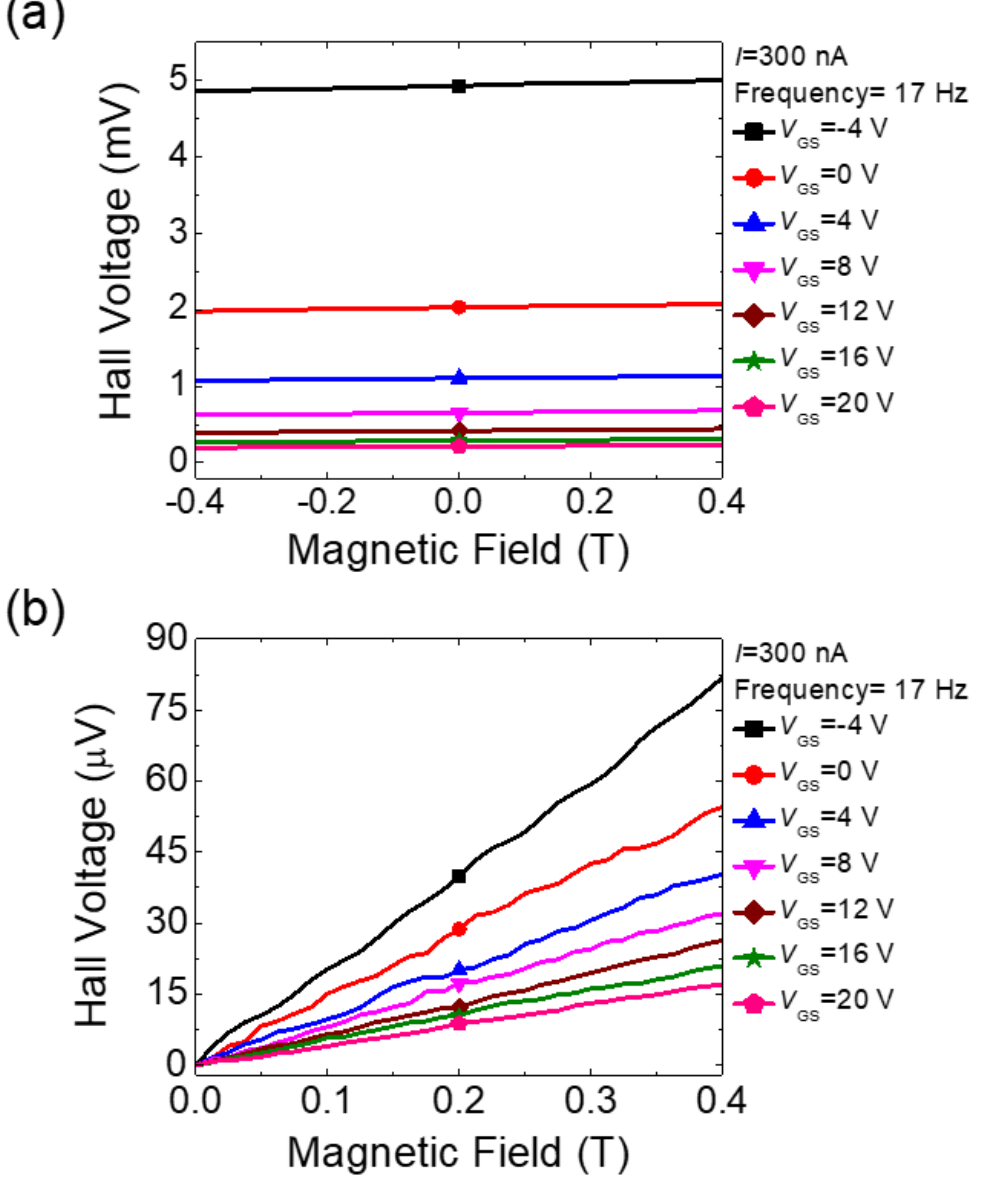
Figure 3. ( a ) Hall voltages as a function of the magnetic field with various gate-source voltages V GS ( − 4, 0, 4, 8, 12, 16, and 20 V); a 17-Hz, 300-nA sinusoidal current was used. ( b ) Hall voltages with offset corrected by applying magnetic field reversal measurement data.